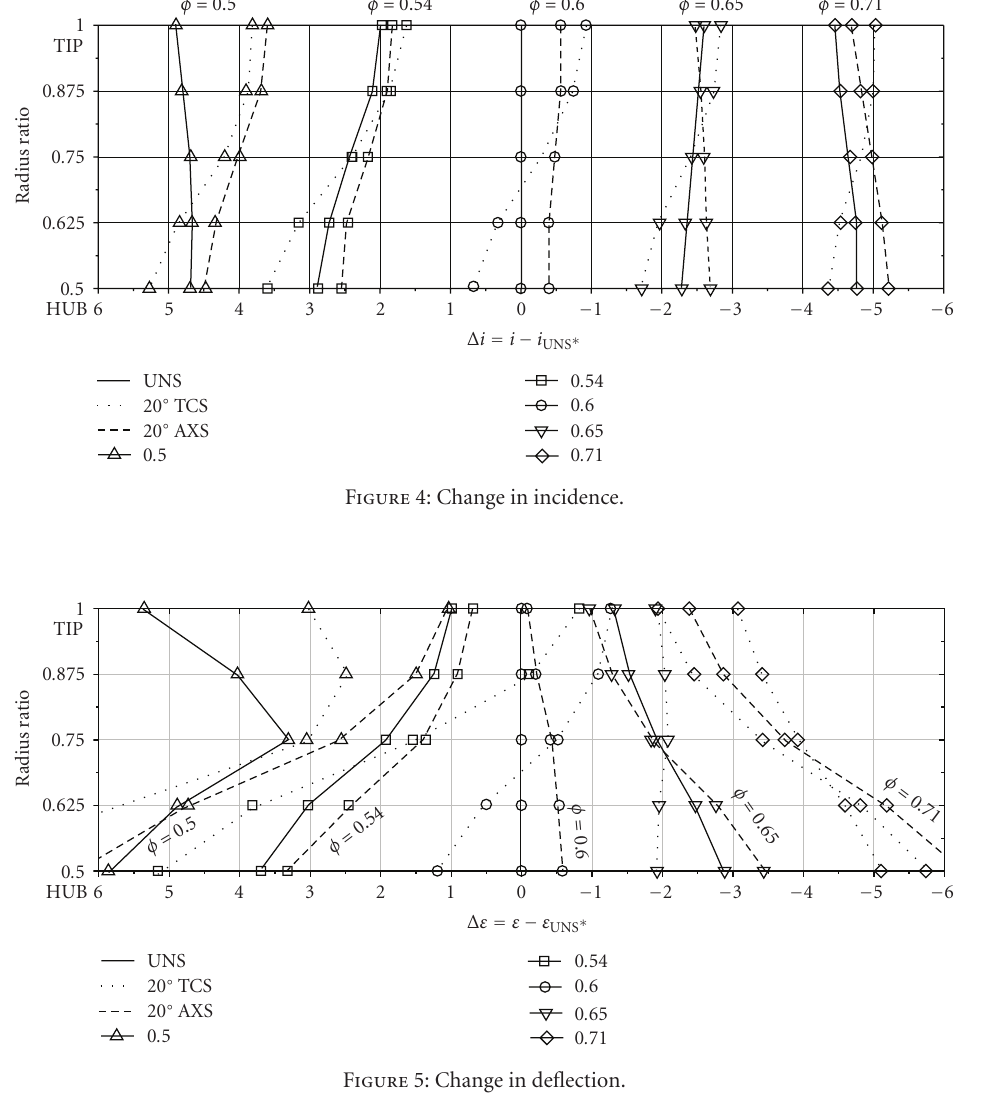
Figure 5: Change in deflection.